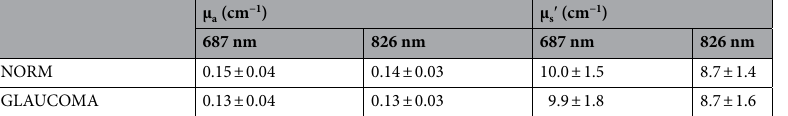
Table 1. Optical properties (average ± standard deviation over subjects and positions) in healthy subjects (NORM) and patients (GLAUCOMA) at 687 nm and 826 nm. μ a absorption coefficient ; μ s ′ scattering